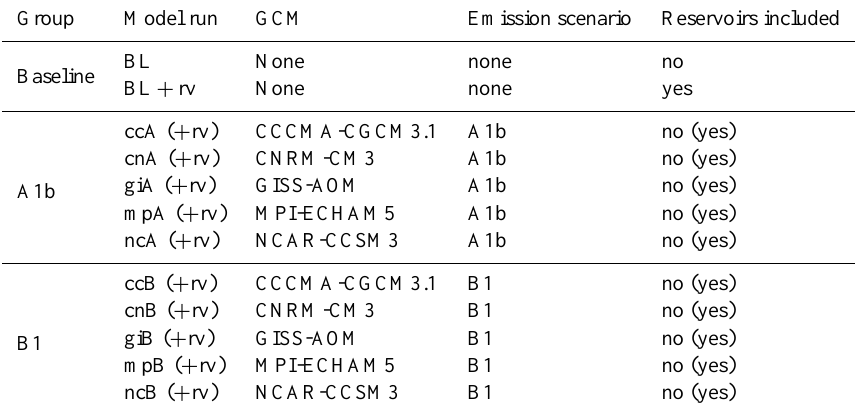
Table 4. Hydrological model runs and their settings used in this study. BL stands for baseline simulation, + rv stands for reservoirs (i.e. reservoir operation included in the